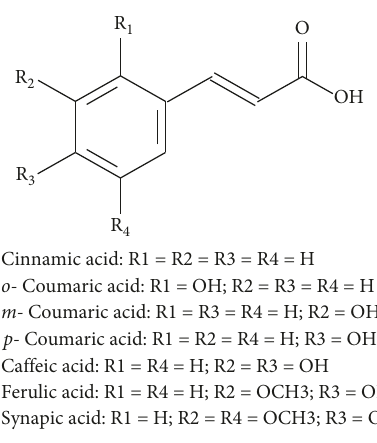
Figure 3: Chemical structure of major cinnamic acids. Cinnamic acid: R1 � R2 � R3 � R4 � H. o -Coumaric acid: R1 � OH; R2 � R3 � R4 � H. m- Coumaric acid: R1 � R3 � R4 � H; R2 � OH. p- Coumaric acid: R1 � R2 � R4 � H; R3 � OH. Caffeic acid: R1 � R4 � H; R2 � R3 � OH. Ferulic acid: R1 � R4 � H; R2 � OCH3; R3 � OH. Synapic acid: R1 � H; R2 � R4 � OCH3; R3 �